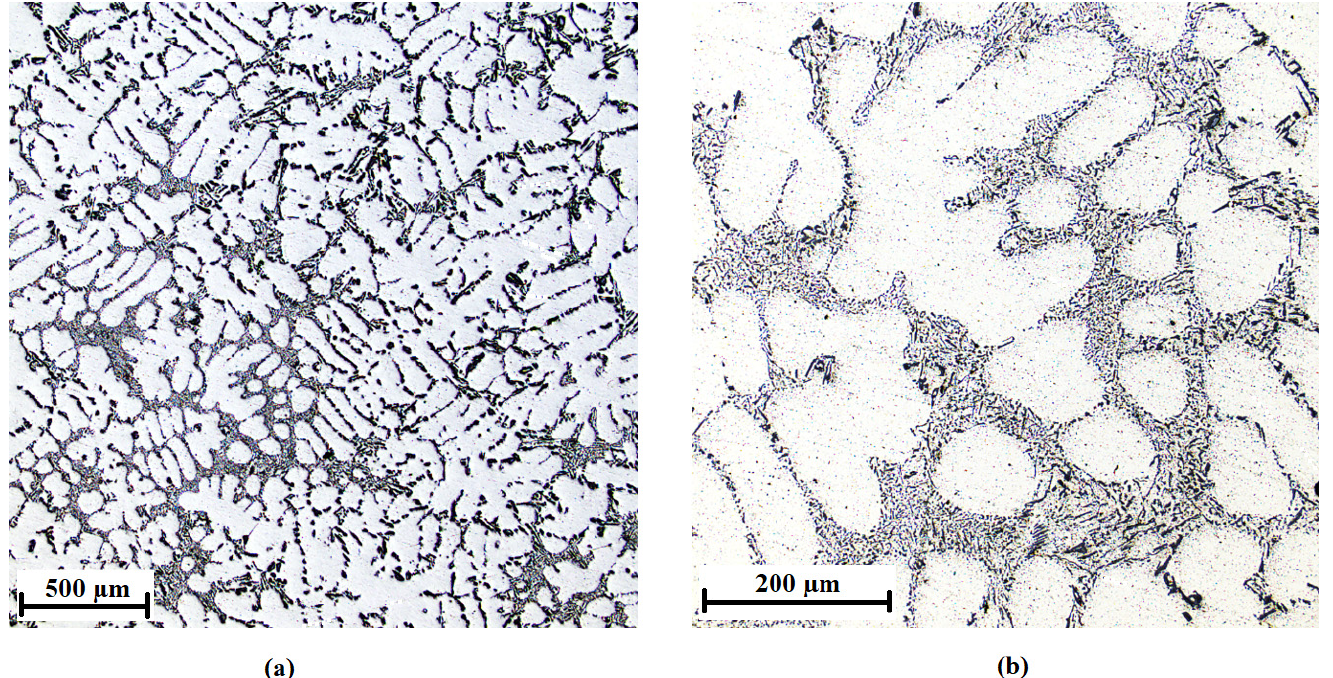
Figure 15. Microstructure of the AlSi7Mg0.3 alloy with the addition of 0.01 wt % AlTi3B1: ( a ) low- magnification overview, ( b ) detail.